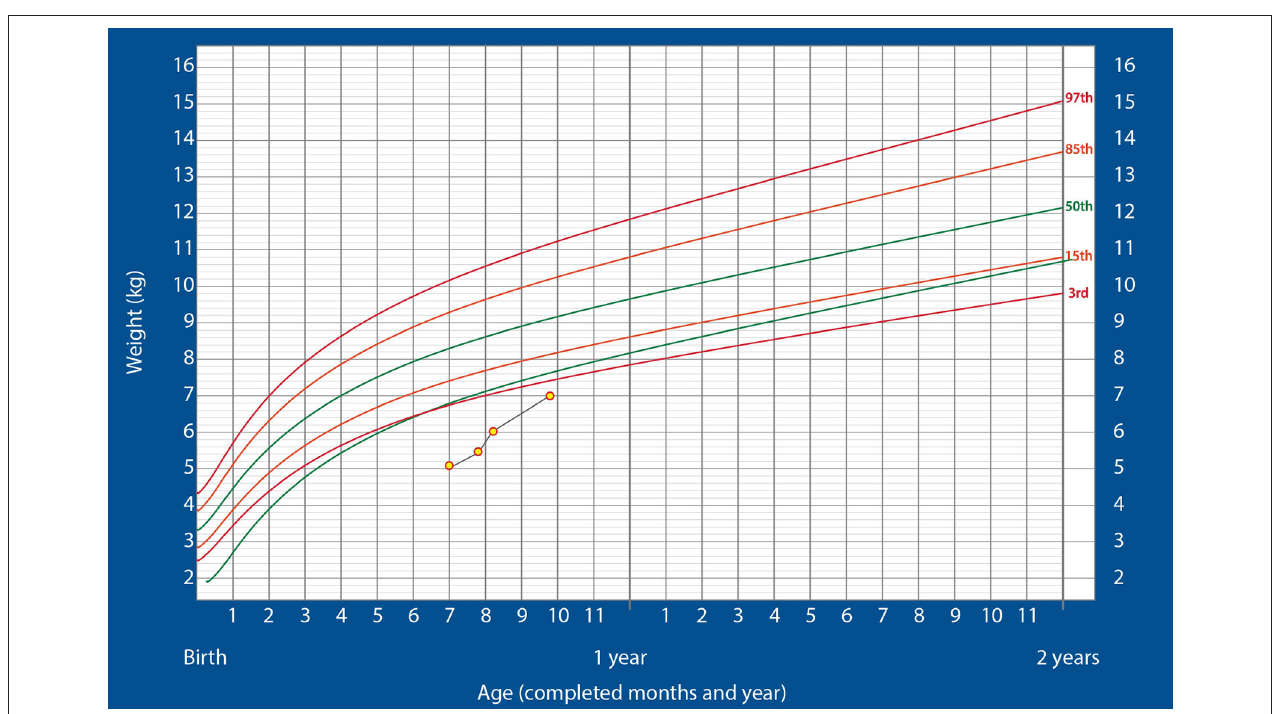
FIGURE 1 | Changes in the weight of the infant over time, plotted on the standardized WHO weight-for-age growth chart for boys (Case